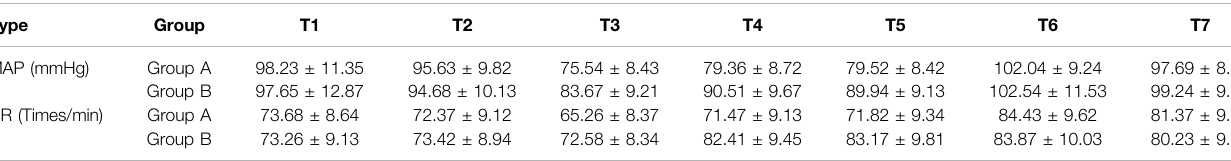
TABLE 2 | Comparison of vital signs between the two groups (n = 40).